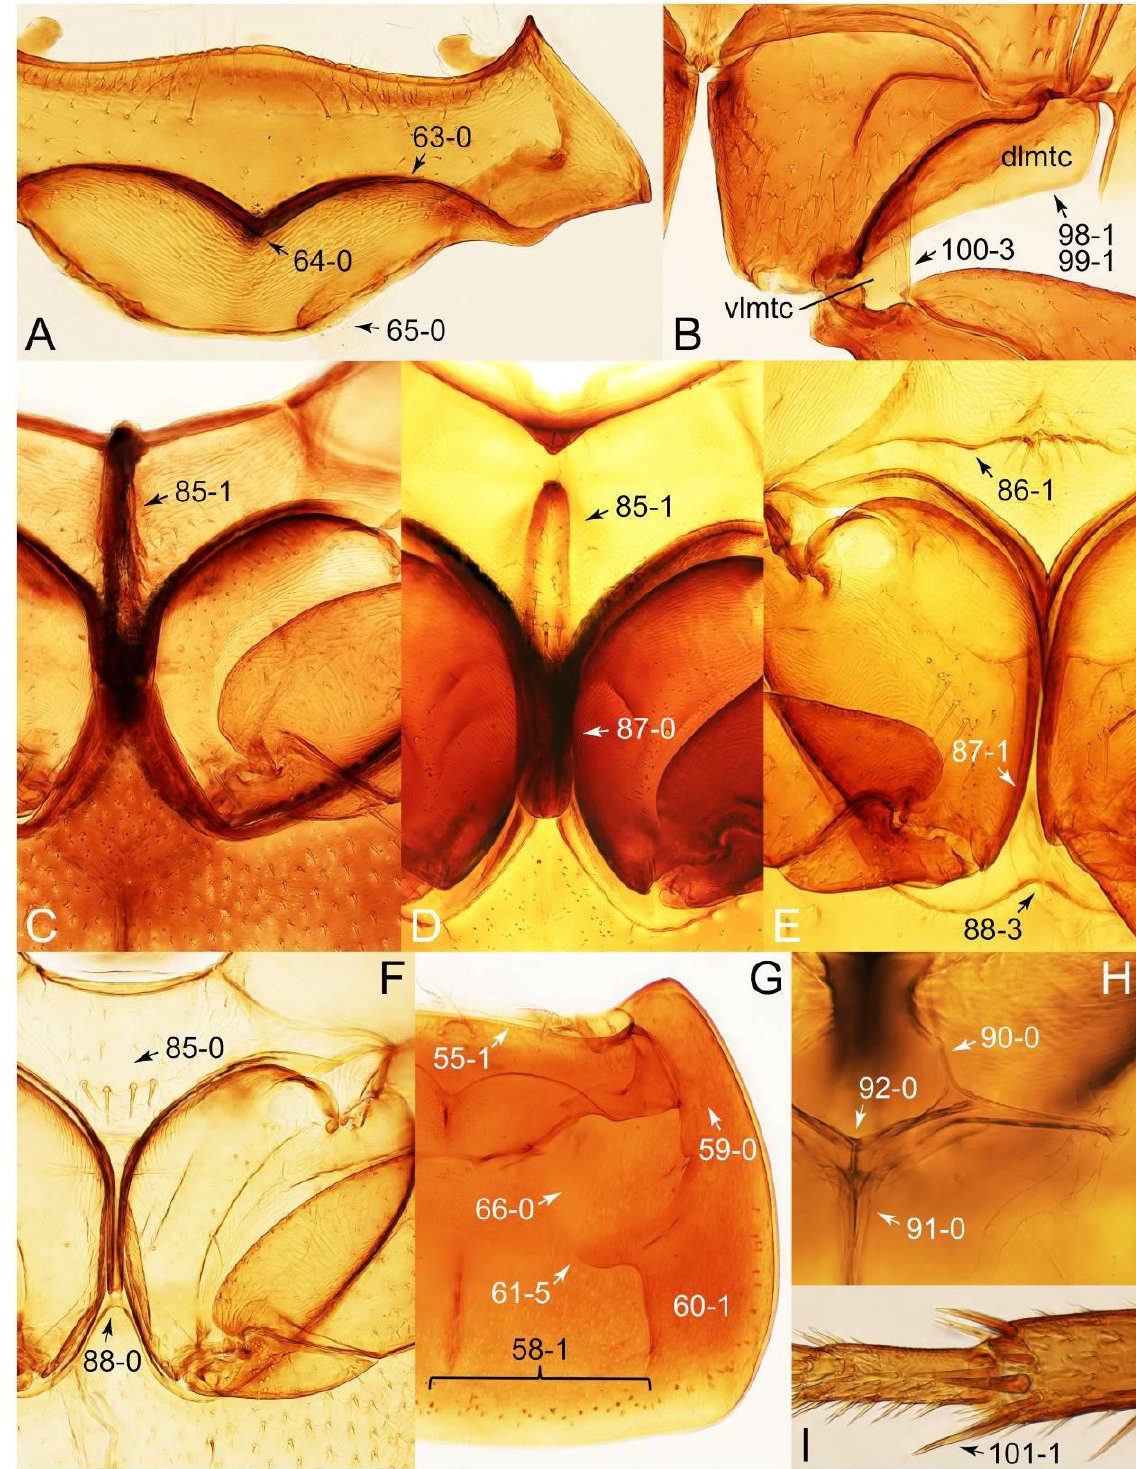
Figure 54. Photographs of body parts of Tachinusini, enlarged. ( A ) prosternum of Leucotachinus luteonitens , ventral view. ( B ) left metacoxa of Leucotachinus luteonitens , ventral view. ( C ) intermesocoxal processes of Tachinomorphus grossulus , ventral view. ( D ) intermesocoxal processes of Olophrinus cf. philippinus , ventral view. ( E ) intermesocoxal processes of L . luteonitens , ventral view. ( F ) intermesocoxal processes of Tachinus fumipennis Say, ventral view. ( G ) prosternum and pronotum of Tachinus rufipes , ventral view. ( H ) metendosternite of Nitidotachinus scrutator (Gemminger & Harold), dorsal view. I, metatarsomere 1 and metatibial spines of Tachinomorphus grossulus . Abbreviations: dlmtc, dorsal lamella of metacoxa; vlmtc, ventral lamella of metacoxa. Characters and character states (format X-X) are indicated on each